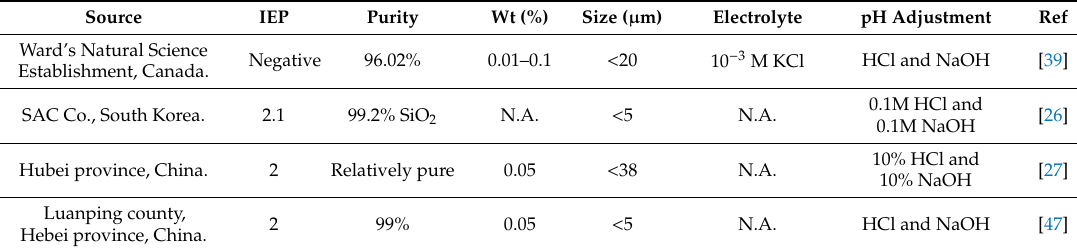
Table 7. IEP values of quartz and measurement